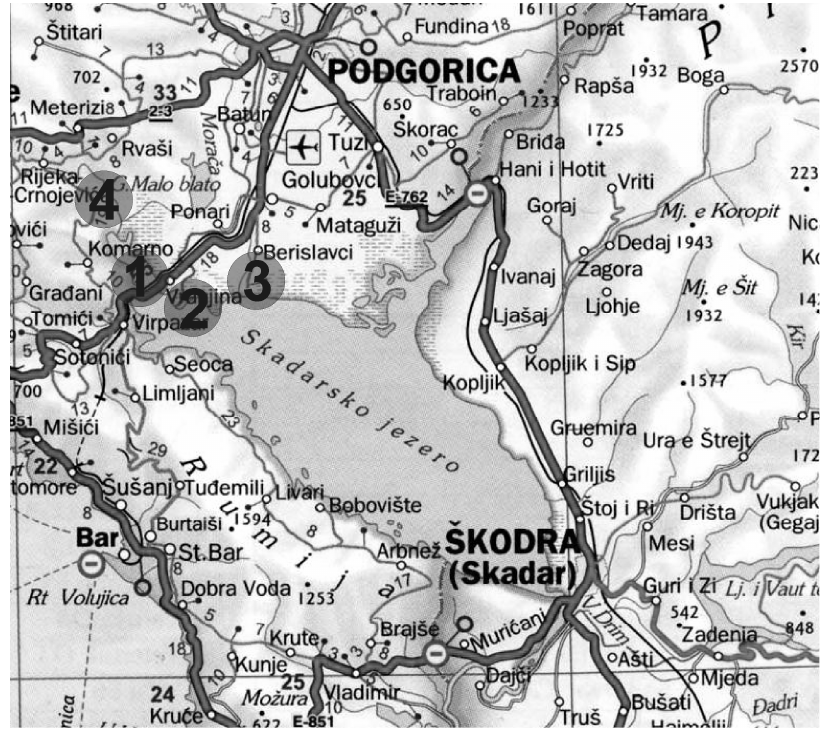
Fig. 1. Location of the sampling sites around Lake